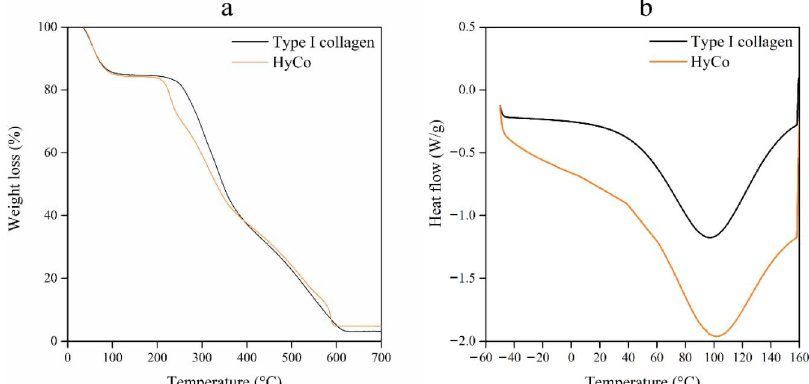
Figure 2. TGA and DSC analyses of commercial collagen scaffold and HyCo. TGA thermograms within the warming range from 0 to 700 ◦ C ( a ); DSC profiles were recorded using a calorimeter with samples shielded in aluminum containers in the temperature range of − 50 ◦ C and 160 ◦ C in nitrogen atmosphere. The DSC scan shows an endothermic peak at 100 ◦ C attributed to water loss/evaporation ( b